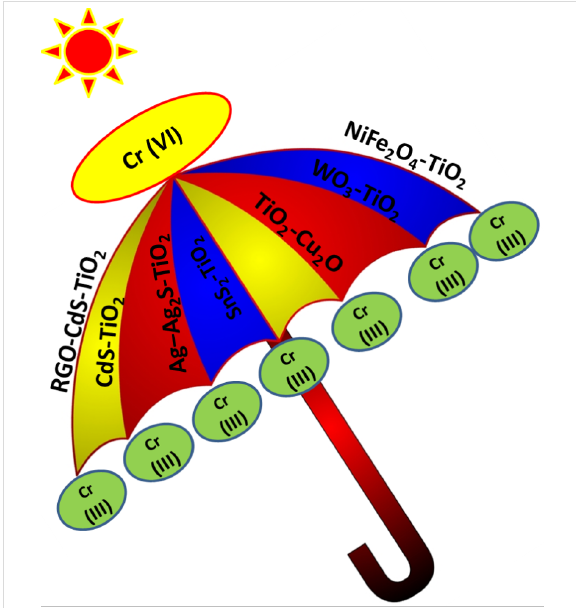
Figure 13: Summary of narrow band gap semiconductors that can be combined with TiO 2 for effective photocatalytic reduction of Cr(VI) through solar energy